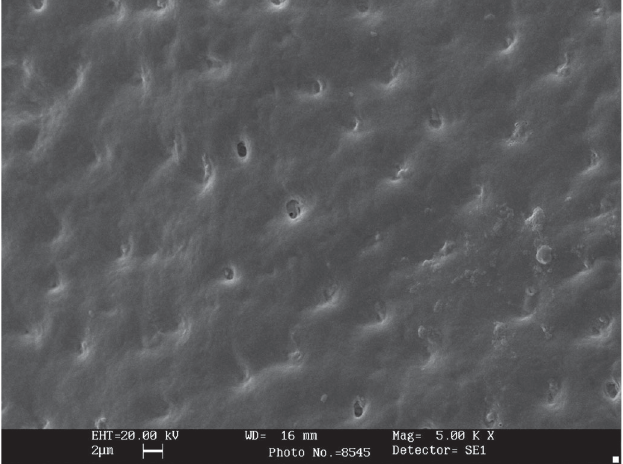
Fig. 7 - SEM image of the ScaTeg showing uniform demineralization of the dentin tubules, absence of smear layer and smear plug, and no tetracycline gel residues.